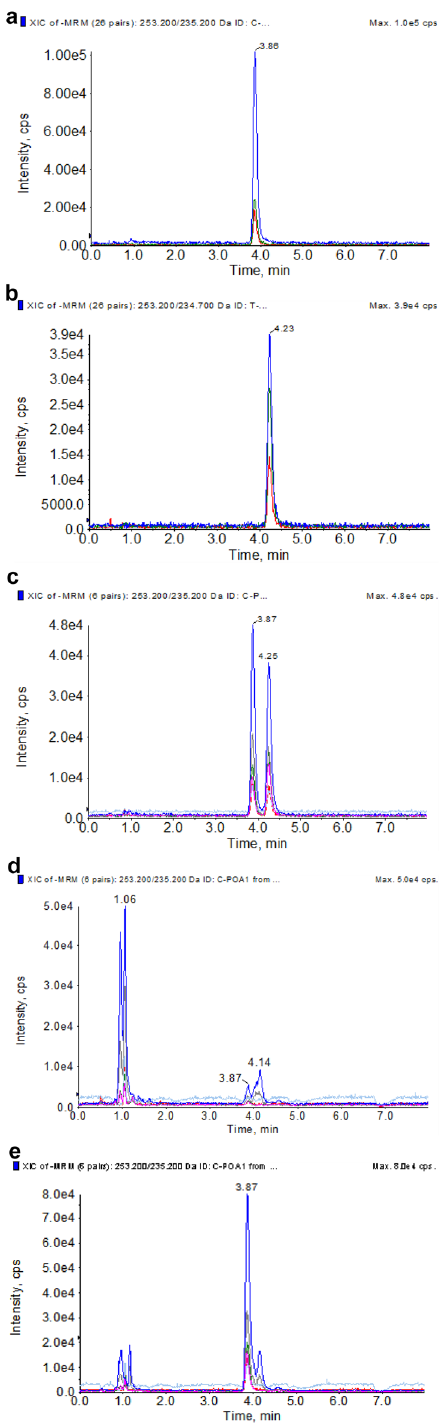
Figure 2. MRM chromatograms of c POA and t POA. ( a ) total ion chromatogram spiked with c POA standard sample, ( b ) total ion chromatogram spiked with t POA standard sample, ( c ) total ion chromatogram spiked with c POA and t POA standard sample, ( d ) blank rat serum sample, ( e ) rat serum sample after c POA intragastric